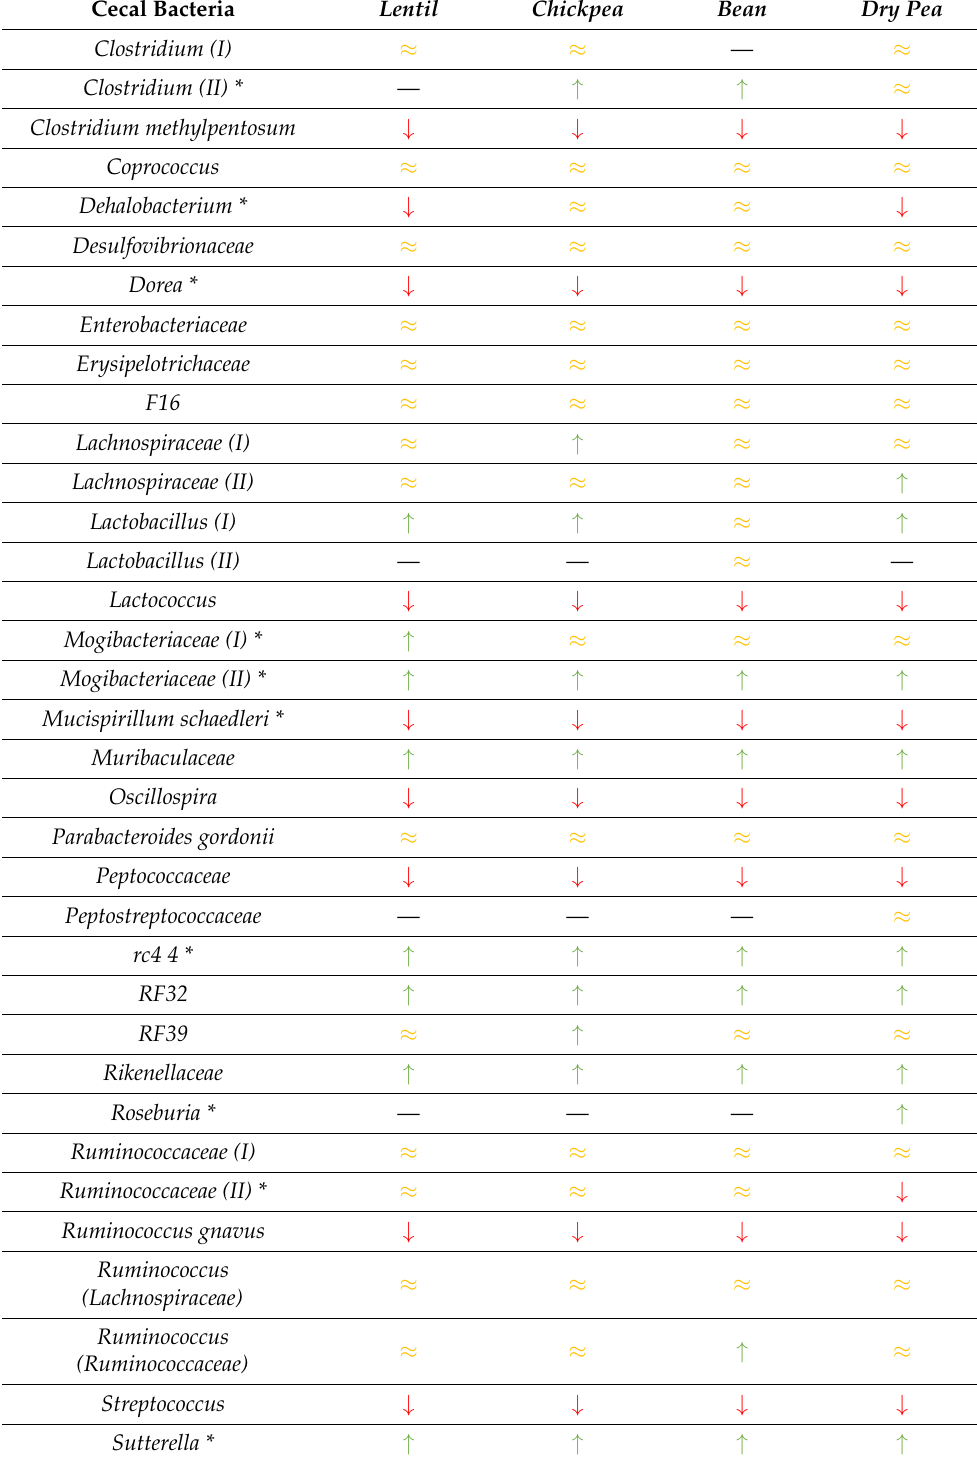
Streptococcus ↓ ↓ ↓ ↓ Sutterella * ↑